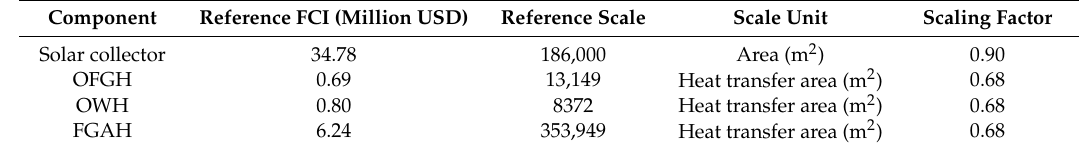
Table 6. Basic capital cost data of facilities.